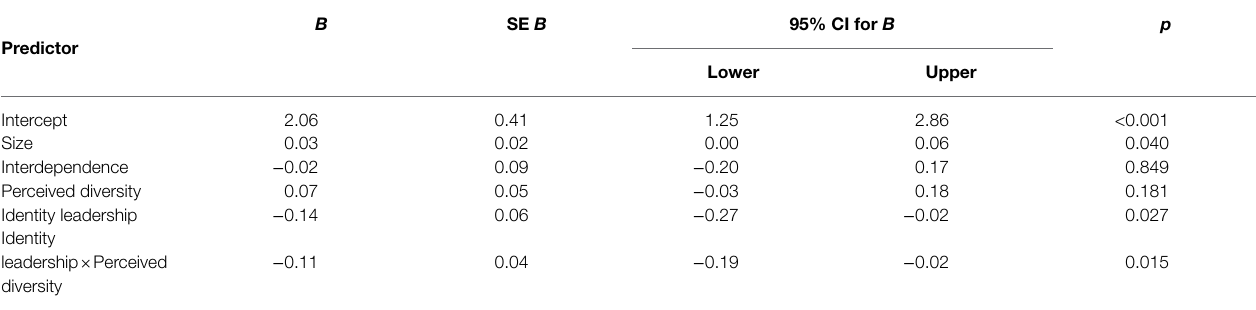
TABLE 3 | Regression coefficients of the moderated regression analysis predicting subgroup formation. B SE B 95% CI for B p Predictor Lower Upper Intercept